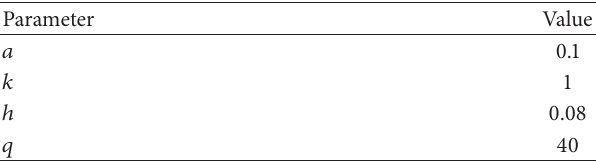
Table 3: Parameter setting of the proposed MPPT